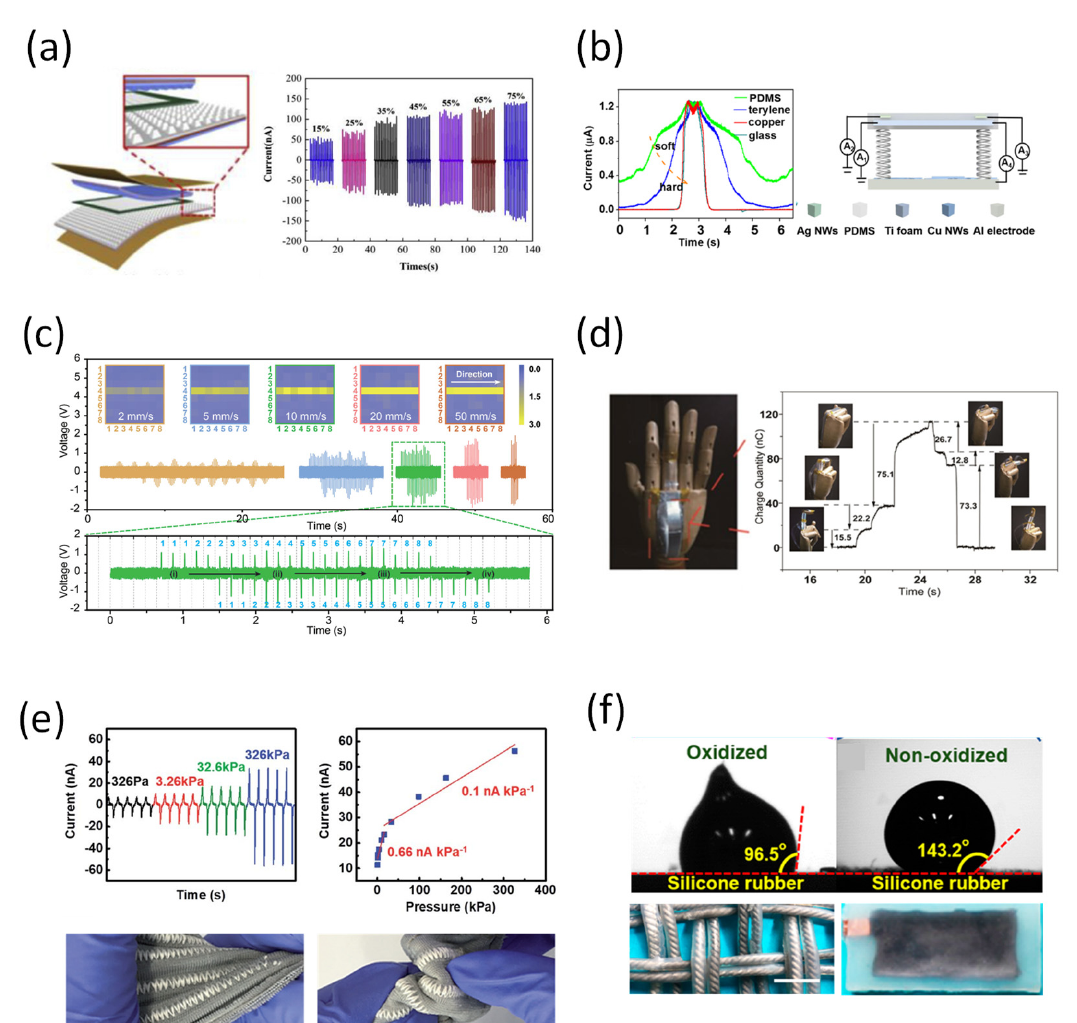
Figure 8. ( a ) Motion sensor constructs from Cu and P(VDF-TrFE) nanofiber pyramid electrode [143]. ( b ) Dual-mode triboelectric nanogenerator for location, pressure, and motion [144]. ( c ) Self-powered, high-resolution, and pressure-sensitive single electrode triboelectric generator based on single-electrode triboelectric generators that enable real-time tactile mapping [145]. ( d ) Triboelectric combined with artificial finger as a self-power sensing system [146]. ( e ) PVDF fiber thread sewed into a fabric using a sewing machine acted as TENG [148]. ( f ) Liquid-metal Galinstan electrode in silicone rubber triboelectric material for super stretchable TENG [149] .